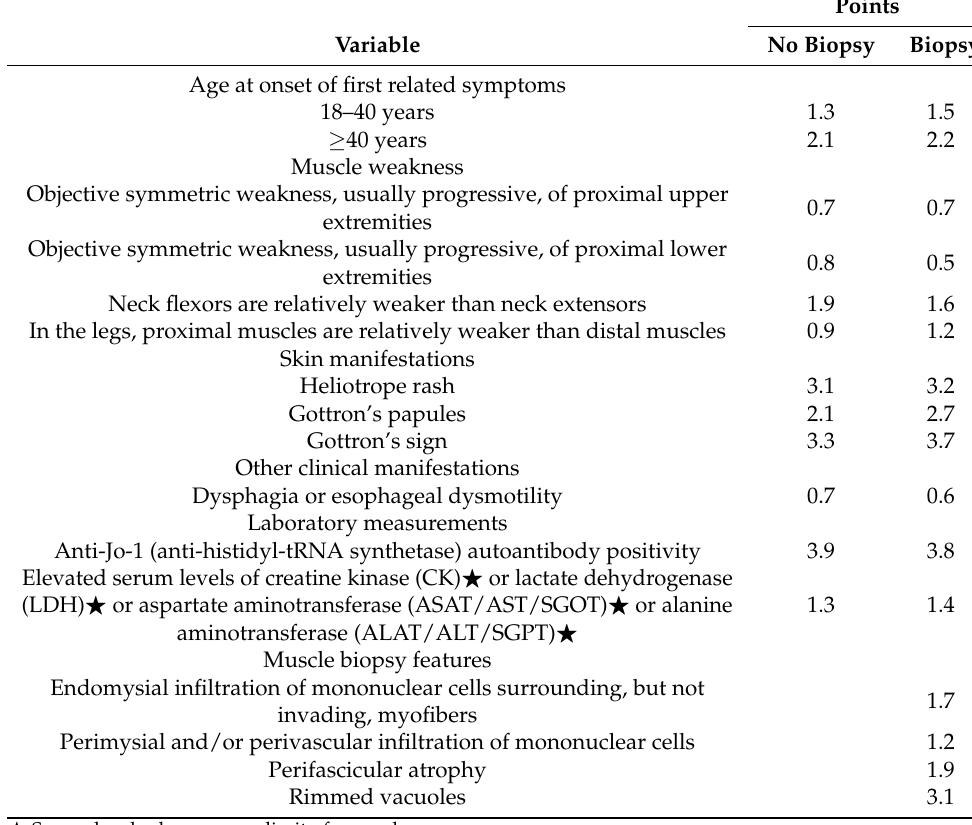
Table 1. Point scores for the European League Against Rheumatism/American College of Rheuma- tology classification criteria for adult and juvenile idiopathic inflammatory myopathies, to be used in the absence of better explanations for symptoms or signs (from the figure in Reference